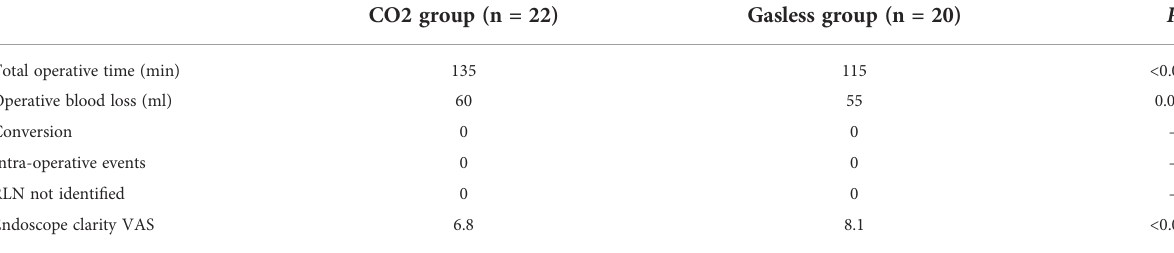
TABLE 3 Intraoperative variables of the two